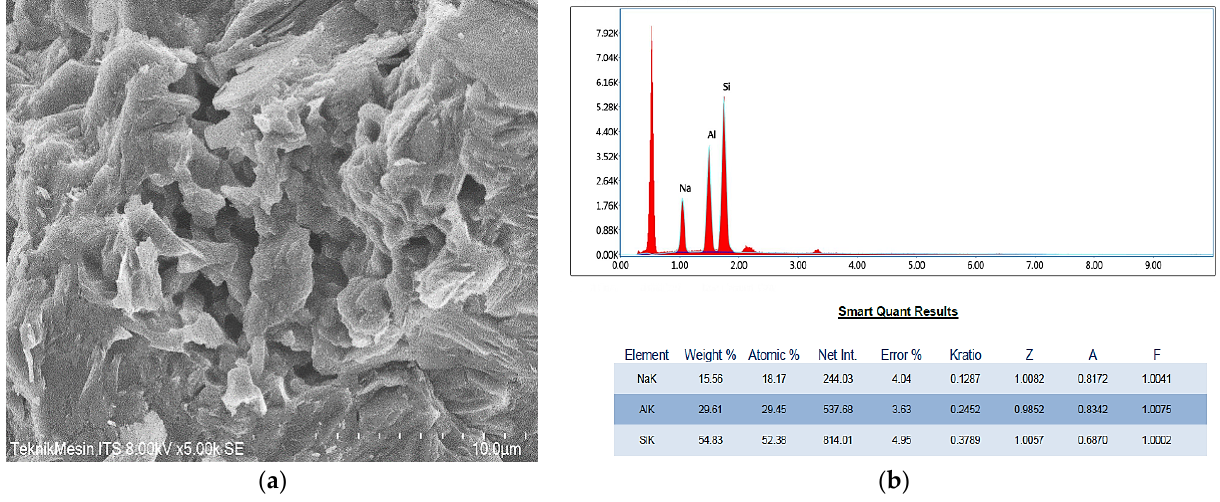
Figure 4. ( a ) Morphology of geopolymer surface and ( b ) EDS spectrum of geopolymer surface which was taken in the whole field area of the image.